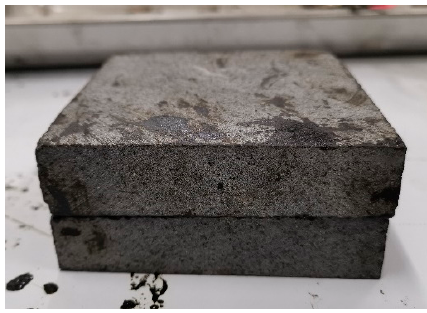
Figure 4. The specimens of the shear bond test.